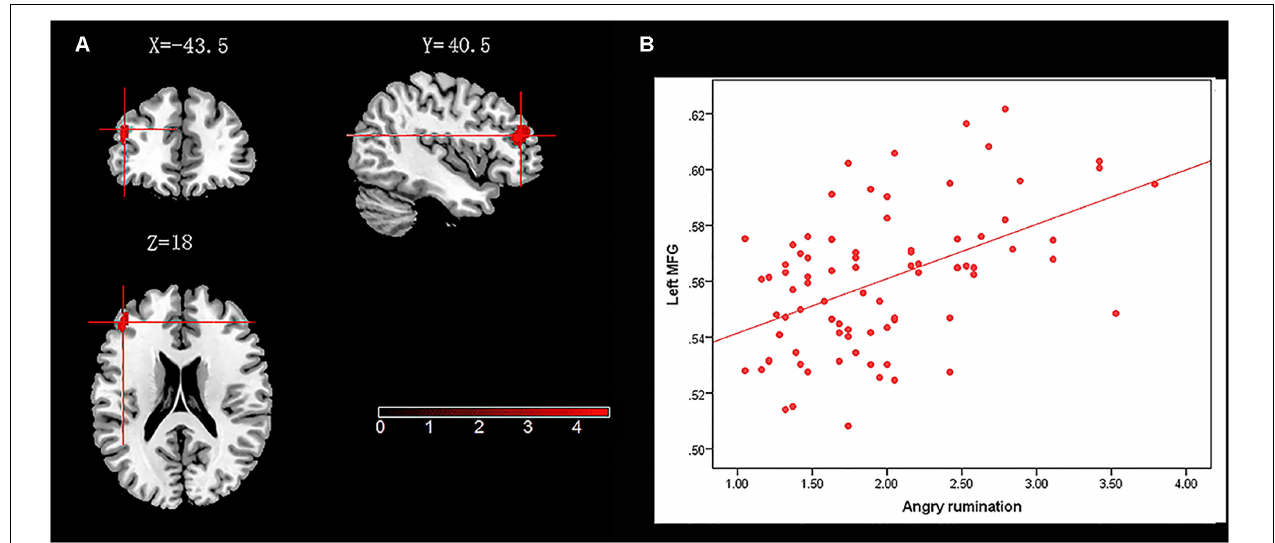
FIGURE 1 | Brain regions that positively correlated with angry rumination. (A) The left middle frontal gyrus (left-MFG) with gray matter (GM) density was positively correlated with angry rumination. (B) Scatter plots depicting correlations between angry rumination and left-MFG.